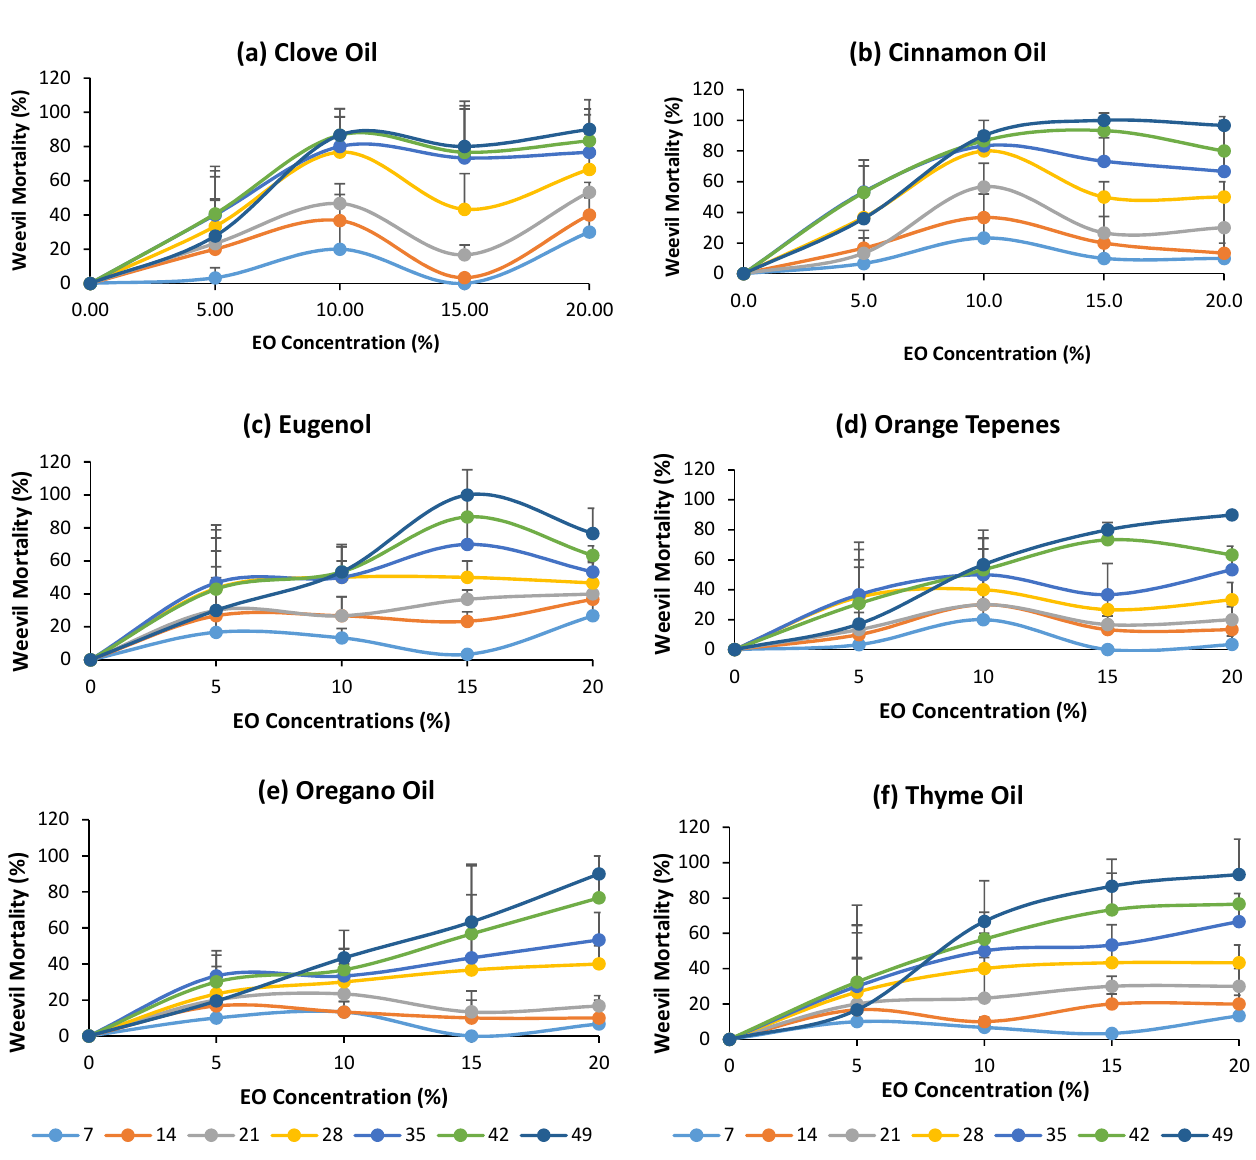
Figure 4. The mortalities of maize weevils in organic corn grains at different concentrations (%) of essential oils.